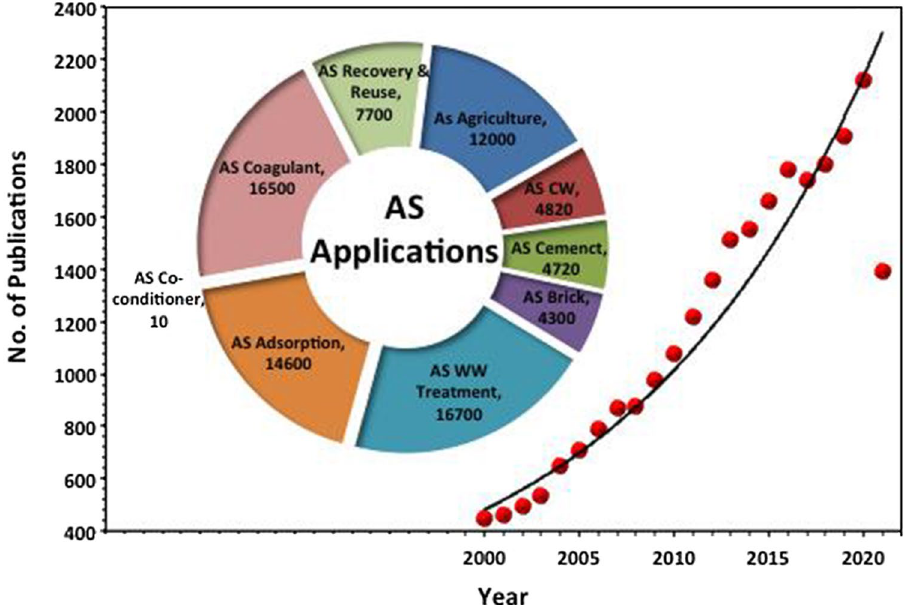
Fig. 3 Joint plotting of